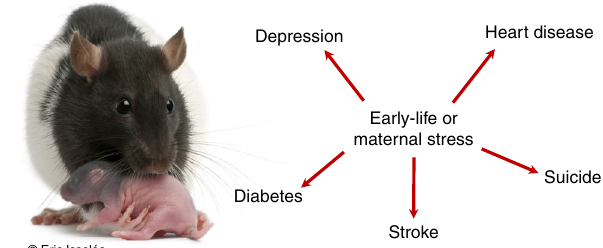
Fig. 2 The early-life environment, including maternal care behaviours, have broad and sometimes long-lasting health outcomes in mammals including humans. Stress reactivity is one iconic example of the effects of maternal stress on offspring behavioural phenotypes later in life. Rat with pup, photo credit: Eric Isselée/Shutterstock. All rights